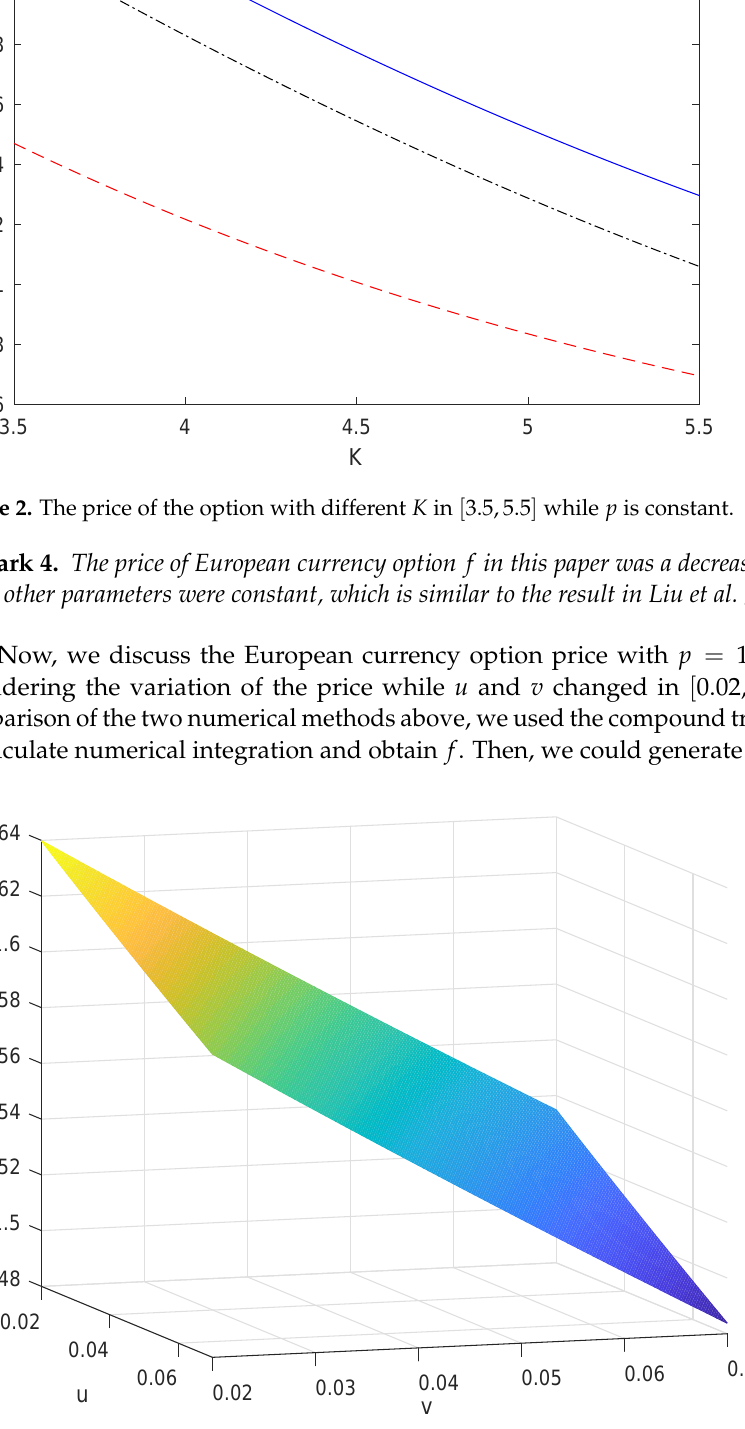
Figure 3. The price of the option with different u , v in [ 3.5,5.5 ] while p = 1.9, K =